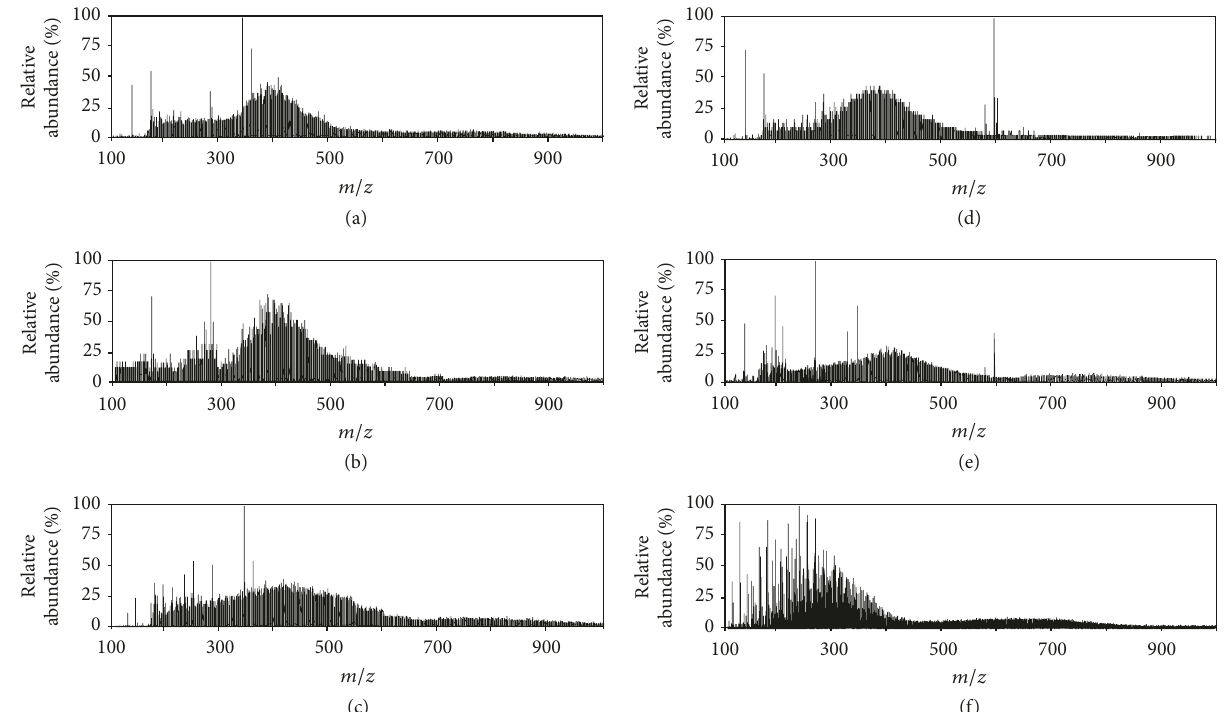
Figure 4: Mass spectra of (a) MEPs 1 -SLL, (b) MEPs 1 -SFB, (c) MEPs 1 -JCA, (d) MEPs 2 -SLL, (e) MEPs 2 -SFB, and (f) MEPs 2 -JCA, obtained by DART-TOF-MS.